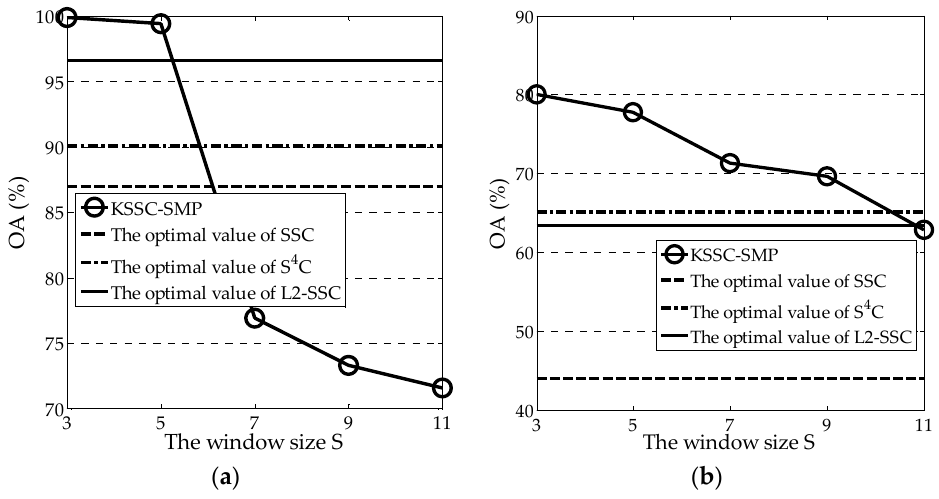
Figure 7. Analysis of the window size parameter S in the clustering performance for both image scenes. ( a ) Change trend of OA versus S for the Salinas image. ( b ) Change trend of OA versus S for the University of Pavia image.